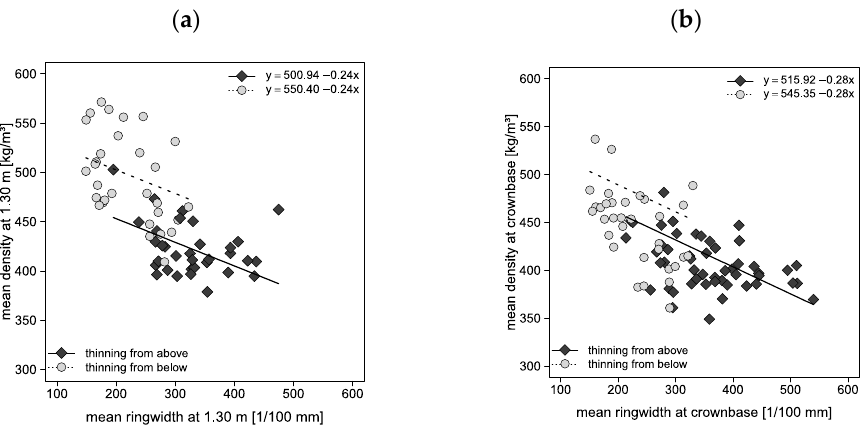
Figure 5. Relationship between mean density and mean ring width at ( a ) DBH and at ( b ) CBH. The lines refer to the applied linear regression models showing significant relationships at p < 0.05. Please note: some density and ring width measurements are missing due to stem rot. Table 3. Results of the linear mixed-effect models (diameter at breast height, DBH; crown base height, CBH) with mean density as response variable and mean ring width as explanatory variable. Given are the parameter estimates, standard error (SE), degrees of freedom (df), t -statistics ( t -value), model significance ( p -value), and marginal R ² ( R ² m ) and conditional R ² ( R ² c ).